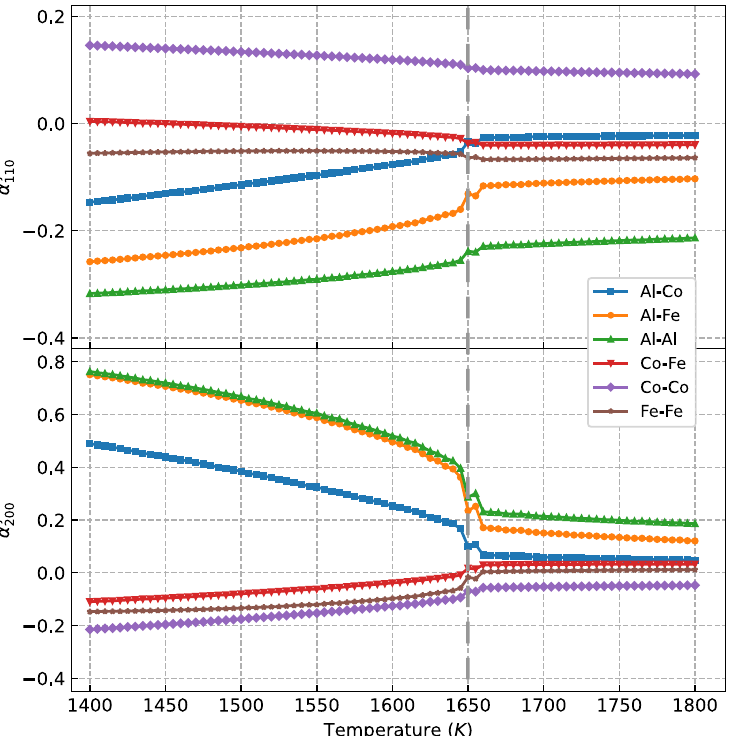
Figure 5. Atomic SRO parameters a ij of AlCoFeNi HEA at the first and second coordination shell lmn from Monte Carlo simulations with the solute interactions from DFT calculations. The dashed line shows the order–disorder transition